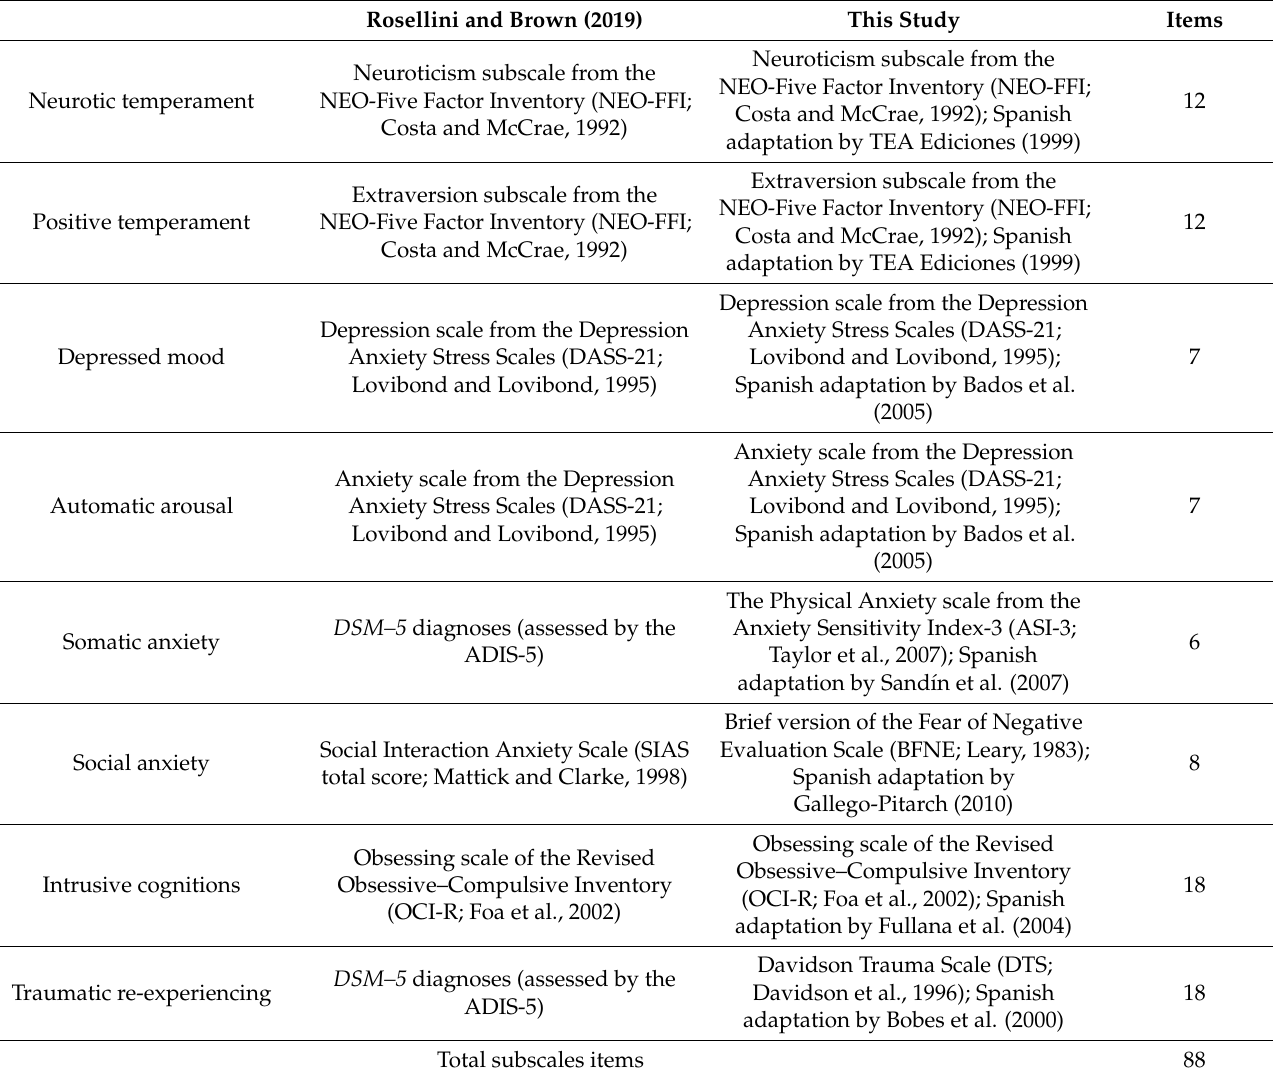
Table 2. Instruments to evaluate the validity of MEDI